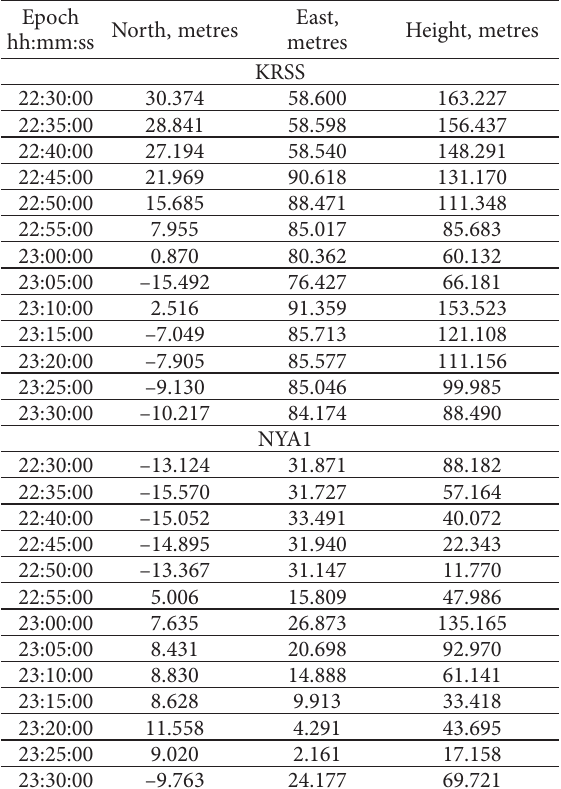
Table 3. The differences of CPOS stations in 2010